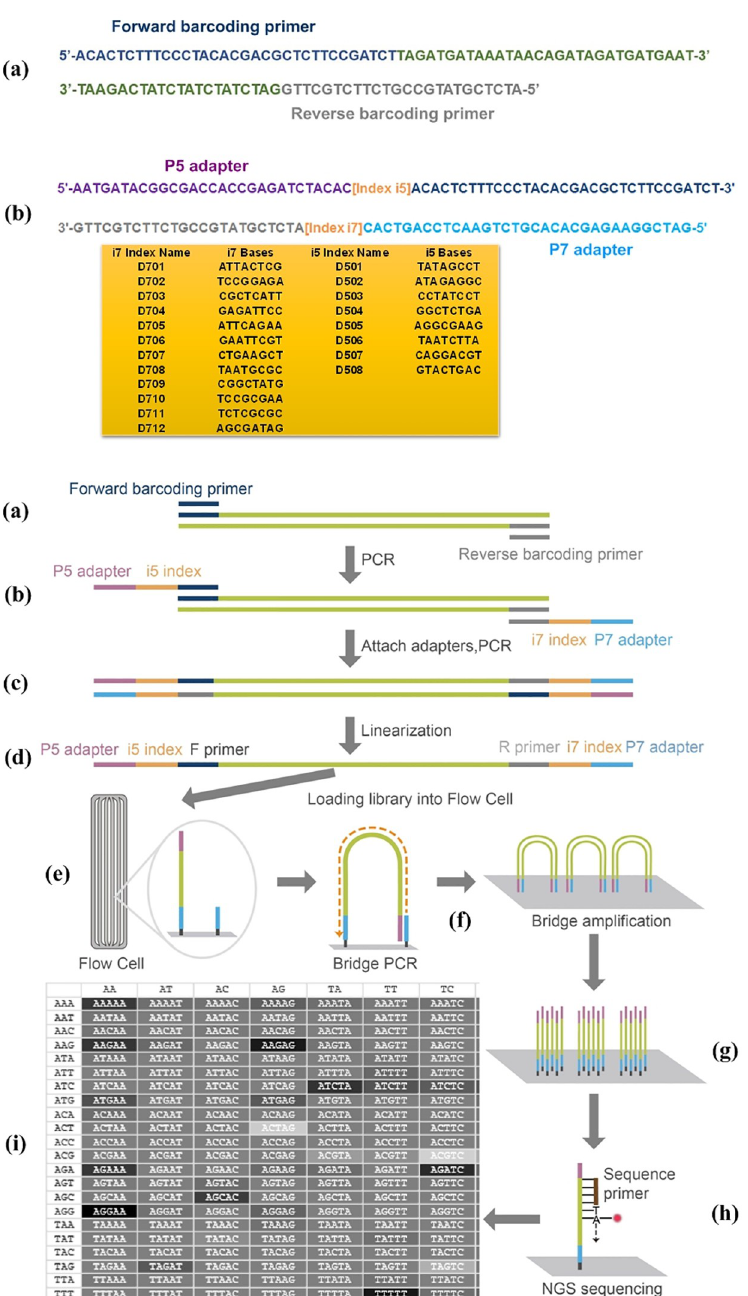
Fig 1. Schematic representation of library preparation and NGS. Data for D3S1358 is shown as a representative example. (a) Amplification of the target sequence with barcoding primers. (b) Second PCR amplification adding specialized adapters and indexes to both ends. (c) Purification of the amplicon and pooling multiple libraries together. (d) Linearization of DNA libraries. (e) Loading DNA libraries onto the flow cell. (f) Bridge PCR amplification. (g) Cluster generation. (h) Paired-end sequencing. (i) Base calling, alignment and data analysis.